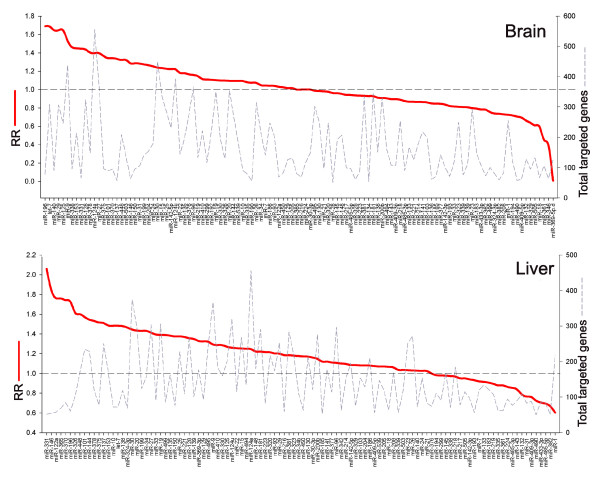
Ranked ratio values for all miRNAs in brain and liver. The miRNAs are ordered by RR values (left-hand y-axis), which are displayed as a red line. The higher values reflect lower expression of predicted target genes and are, therefore, indicative of miRNA activity. The numbers of genes predicted to be targeted by each miRNA (right-hand y-axis) are indicated by the dashed line. Known neural- (for example, miR-29) and liver-specific (for example, miR-122a) miRNAs appear on the left-hand side.